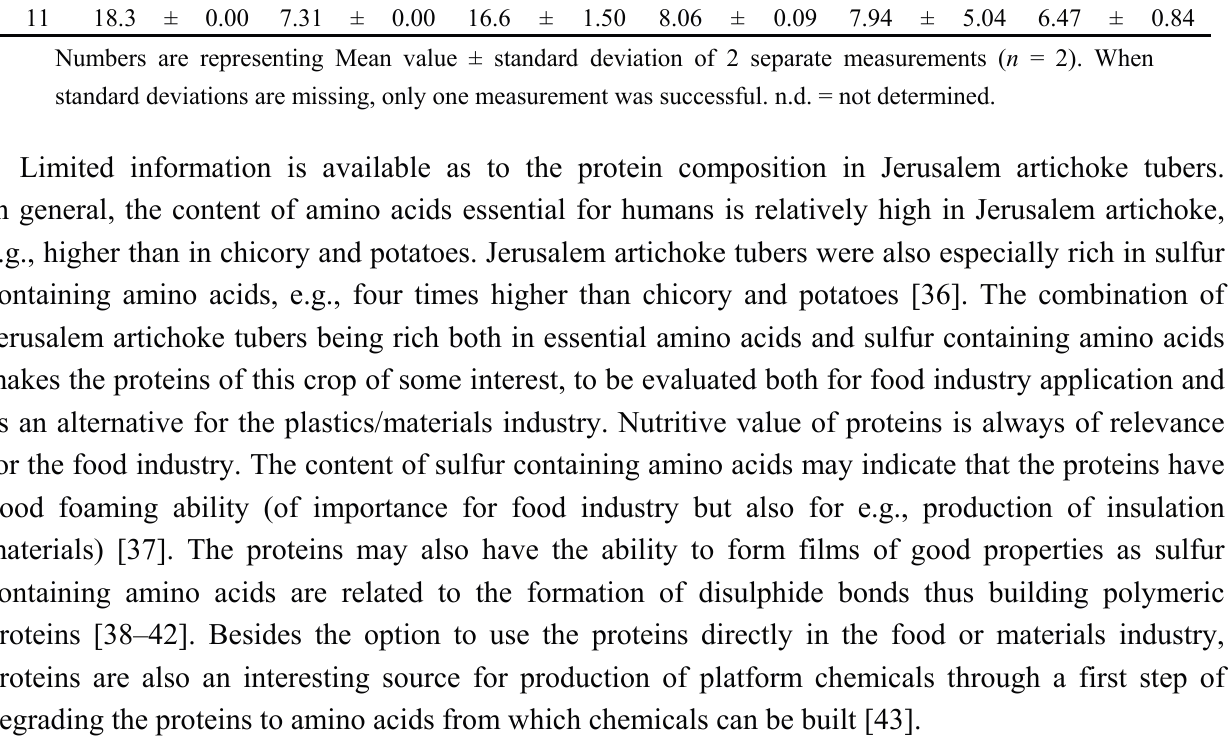
Numbers are representing Mean value ± standard deviation of 2 separate measurements ( n = 2). When standard deviations are missing, only one measurement was successful. n.d. = not